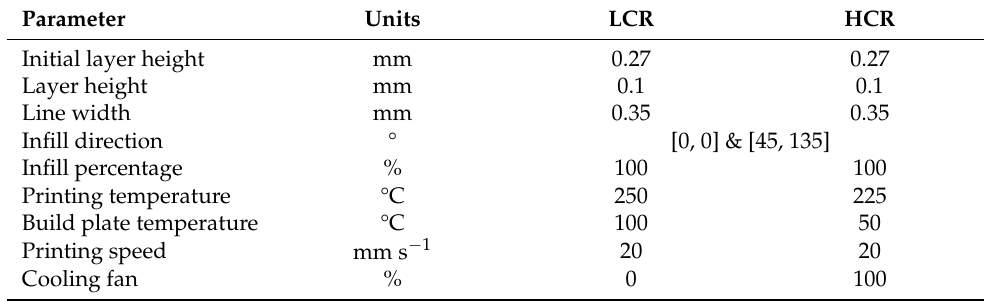
Table 1. 3D printing